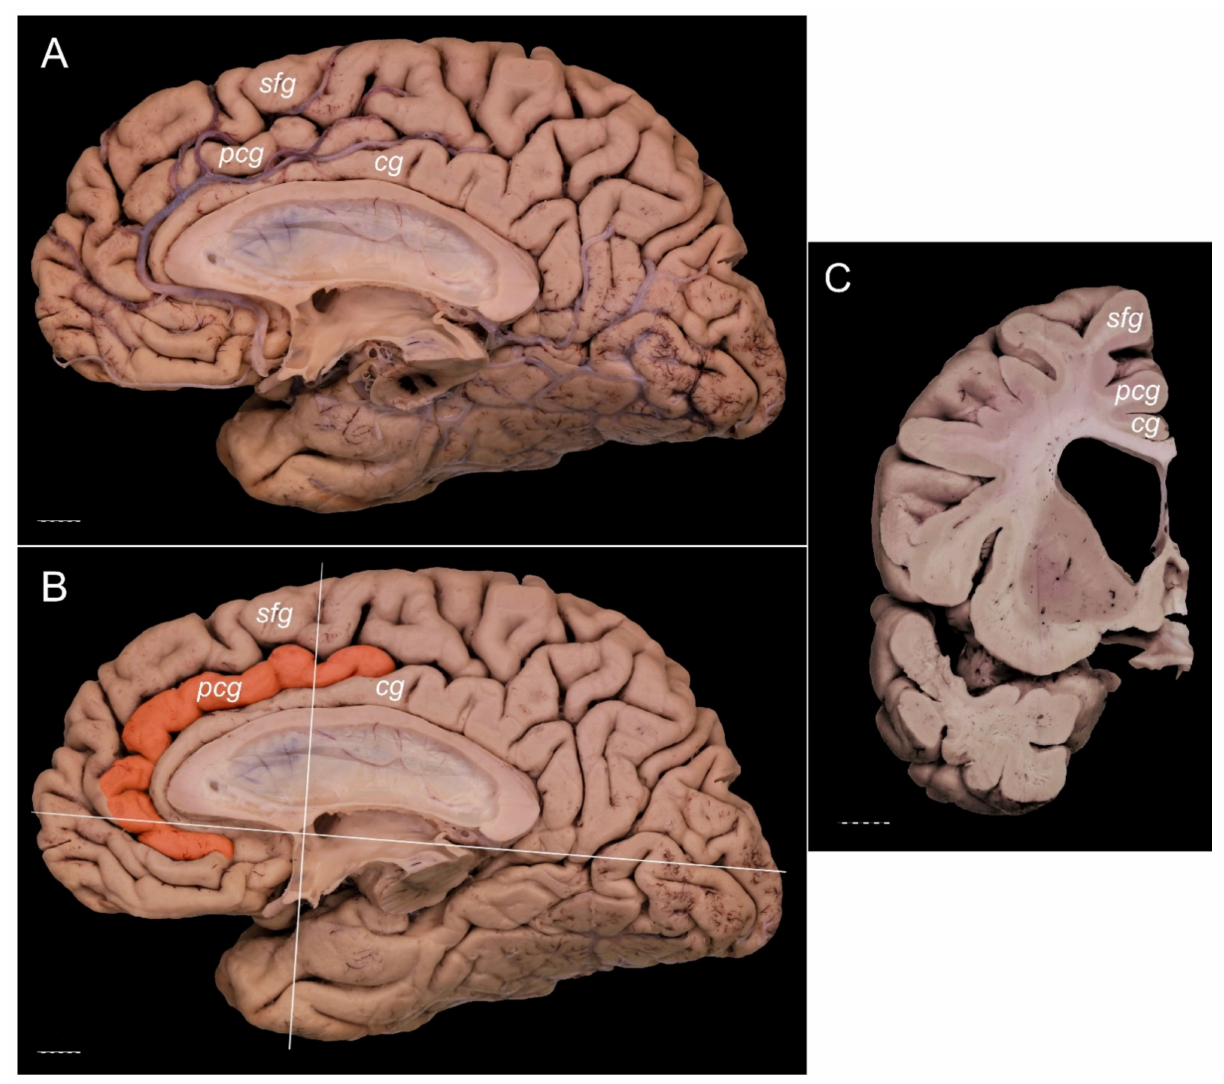
Figure 3. Presence of a prominent PCG. Specimens of the right cerebral hemisphere. The posterior cingulate gyrus crosses the level of the VAC line posteriorly. ( A ) General medial view of the hemisphere with callosomarginal artery running within the cingulate sulcus and sending branches that cross the PCG. ( B ) Medial view of the same specimen with the PCG colored orange. VAC and AC-PC lines are marked. ( C ) Coronal section of the specimen made 10 mm anterior to the VAC. Separate cingulate, paracingulate, and superior frontal gyri are well marked. cg—cingulate gyrus; pcg—paracingulate gyrus; sfg—superior frontal gyrus. The scale bar corresponds to 10